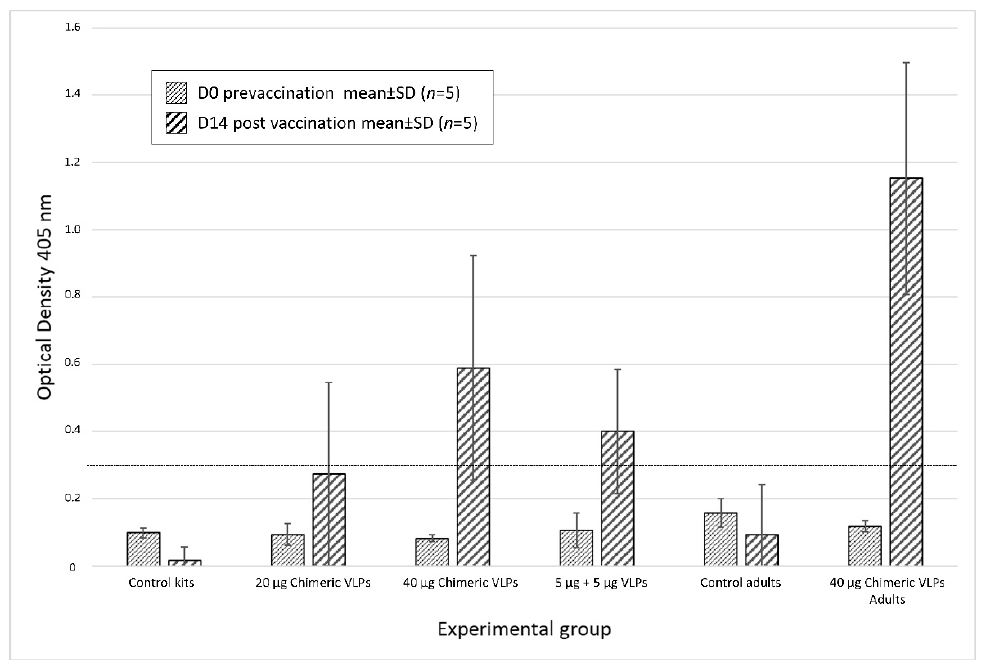
Figure 5. Detection of anti-RHDV antibodies in rabbit sera pre- (D0) and post vaccination (D 14) by ELISA. The graph shows optical density (450 nm) of sera versus mean ± SD ( n = 5) from the four groups of rabbits challenged with RHDV GI.2 (kits of 30 d of age) and two groups (adults 60 d) challenged with GI.1. Sera were analysed using the commercial ELISA a cut-off value of 0.3 is indicated with the dotted line.